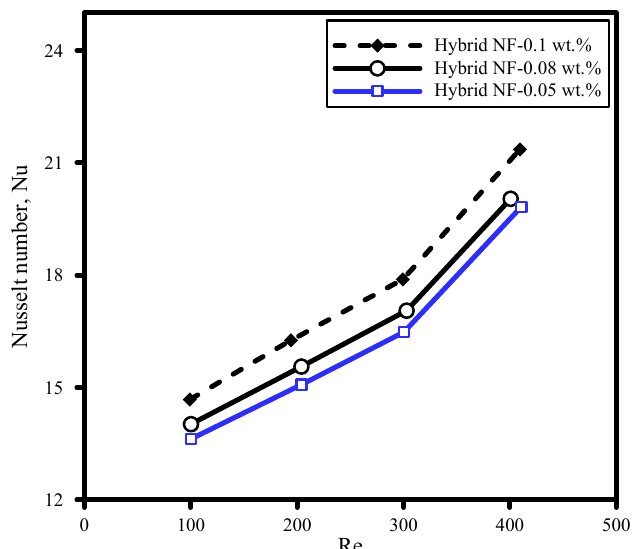
Figure 17. Pumping power of FPSC with water-based (hBN/CF-CNTs) nanofluid for various Reynolds numbers at 960 W/m 2 and 30 °C.